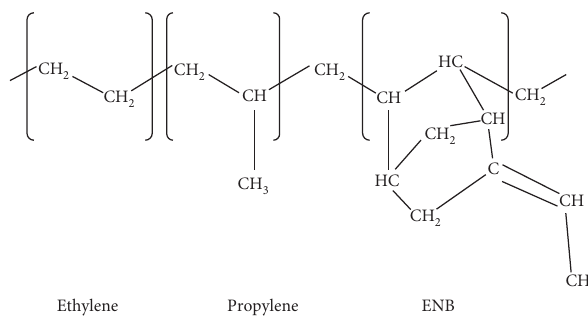
Figure 3: Molecular structure of EPDM.